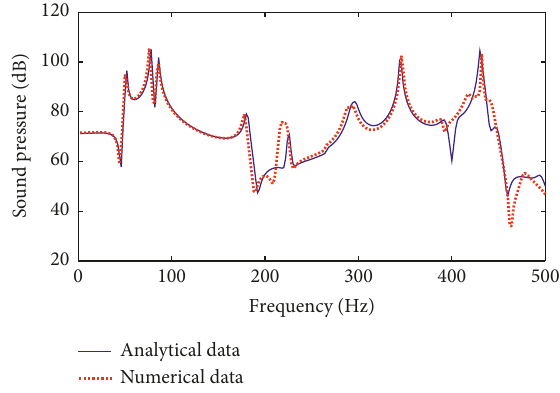
Figure 10: Sound pressure response at the position ( x y b � 0.3 m, and z b � 0.4m) in the acoustic cavity b